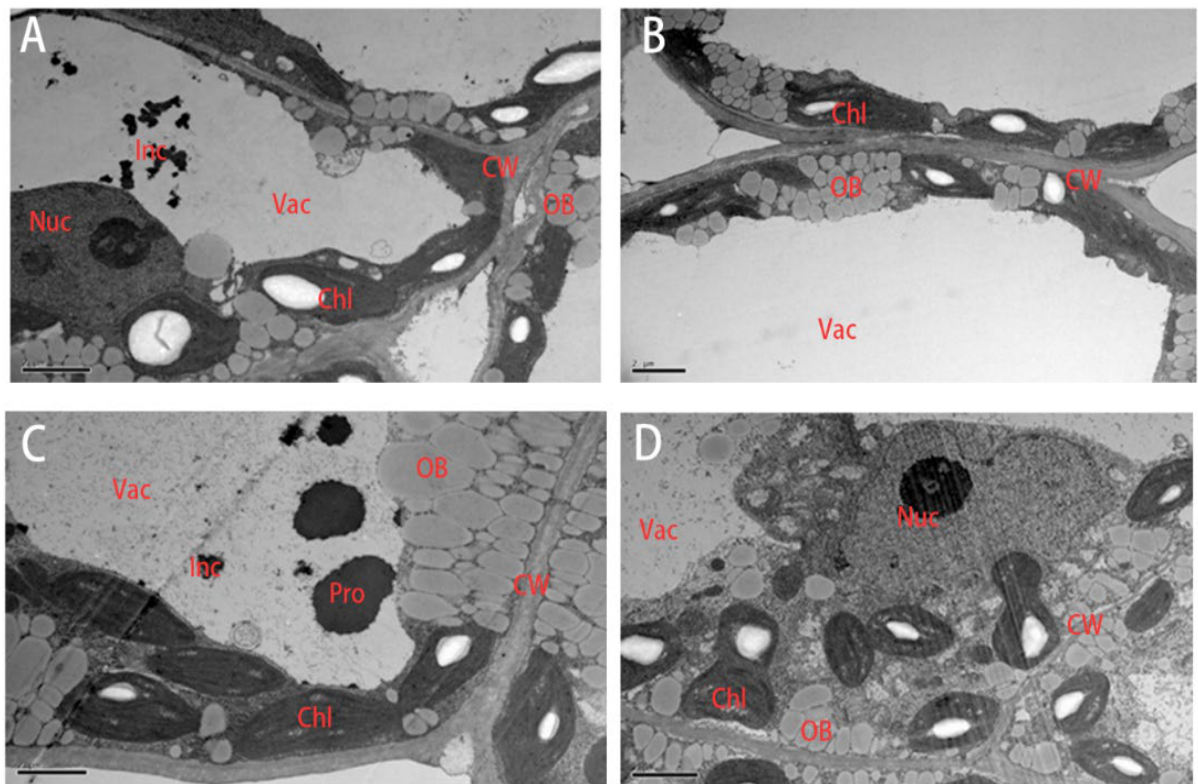
Figure 8. Effects of drought stress (PEG-6000-induced) on the internal structure of seedlings. ( A ) control of tolerant variety, ( B ) control of sensitive variety, ( C ) tolerant variety under 15% PEG-6000 treatment and ( D ) sensitive variety with 15% PEG-6000 treatment.